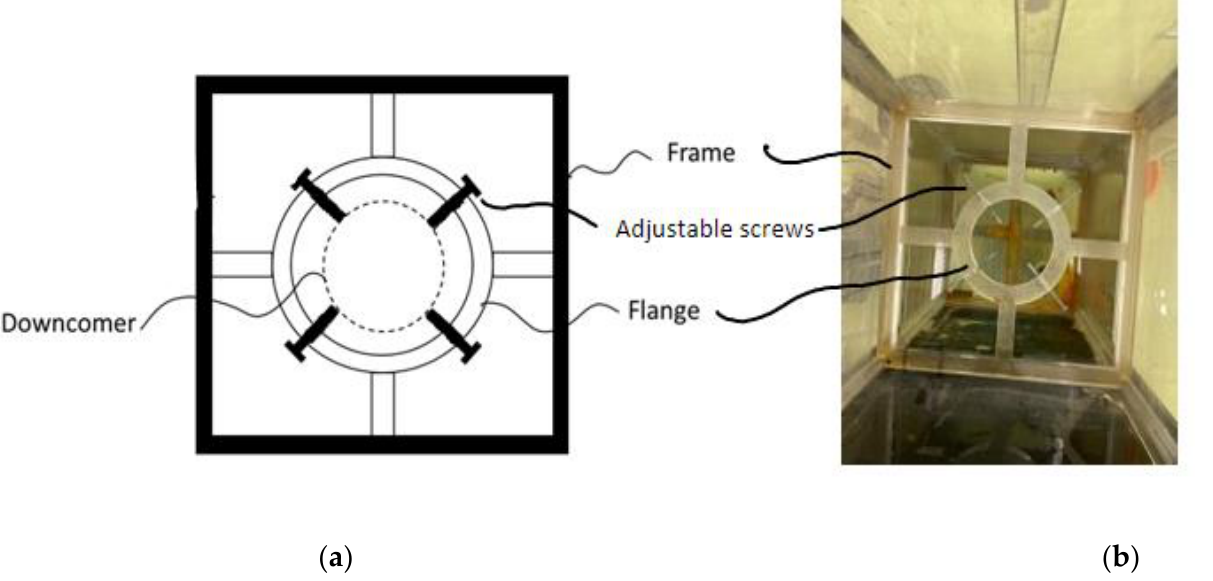
Figure 4. ( a ) Design of the supporting flange/frame that holds the downcomer in position; ( b ) top view of the CPLJR unit showing the supporting flange and other parts (adjustable screws, frame and flange).